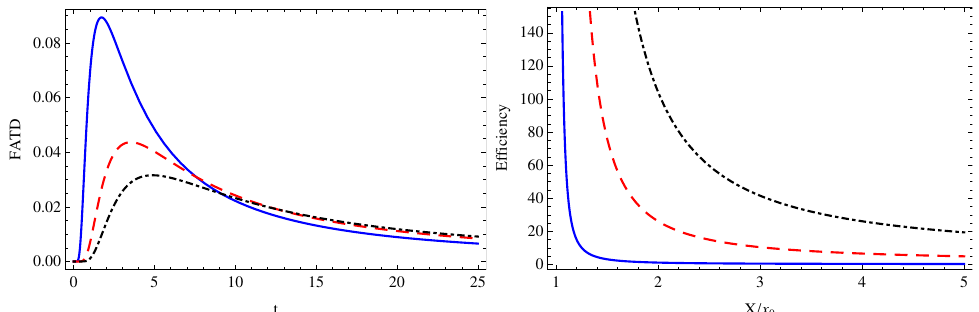
Figure 13. Left panel: FATD (95) for D = 1, v = 1, and X / x 0 = 2.5 (blue solid line), X / x 0 = 5 (red dashed line), and X / x 0 = 7.5 (black dot-dashed line). Right panel: Efficiency (96) for D = 1, V = 1 (blue solid line), v = 5 (red dashed line), and v = 10 (black dot-dashed line).